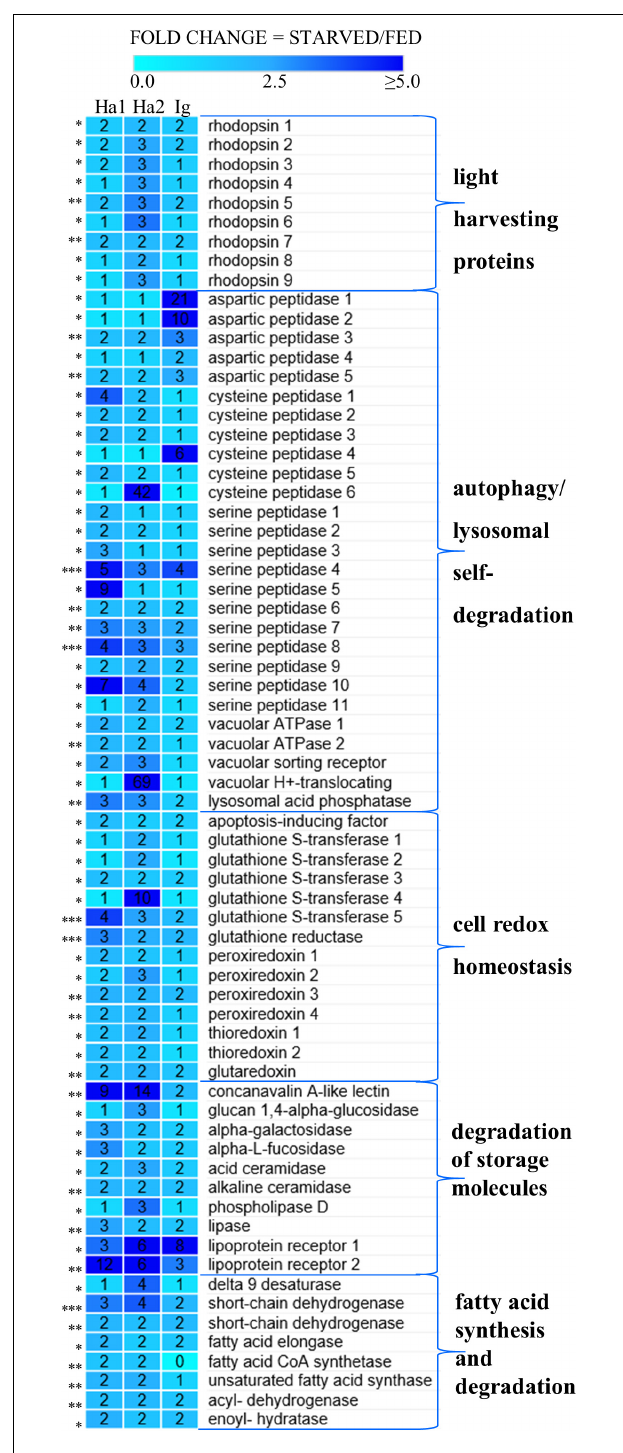
FIGURE 4 | A heat map representing 73 transcripts that were up-regulated in O. marina cells fed on H. akashiwo 1 (Ha1), H. akashiwo 2 (Ha2), and I. galbana (Ig) compared to starved O. marina cells. Numbers inside boxes indicate fold change with each prey treatment and the number of asterisks next to each transcript indicates the number of prey that were significantly differentially expressed. Names, contig IDs, and annotations of the transcripts can be found in Supplementary Files S1, S2 .